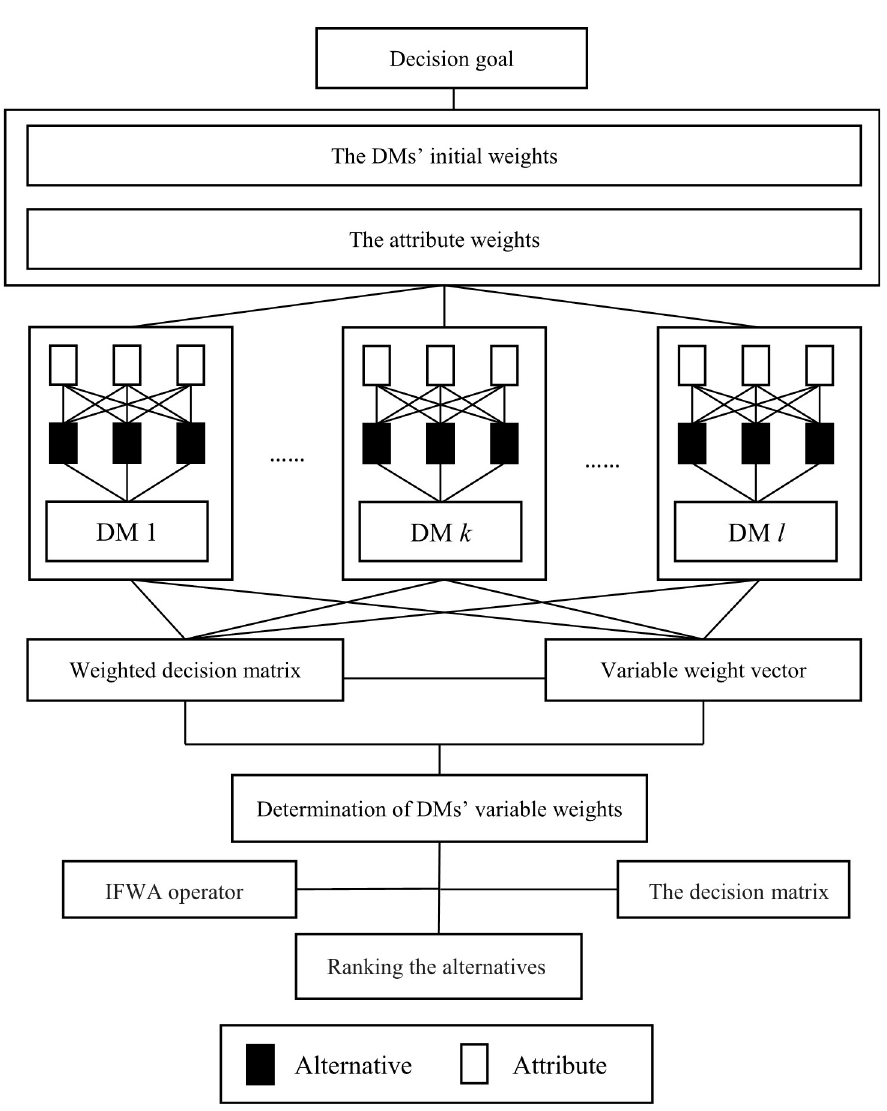
Fig 3. Hierarchical structure of the proposed